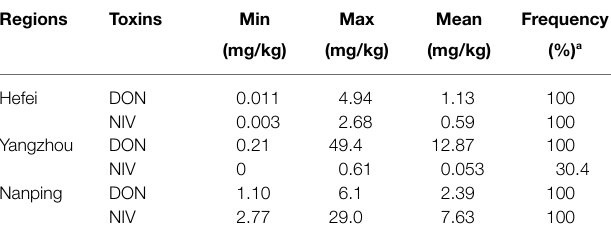
TABLE 1 | The concentration of mycotoxins in the three ecological regions.